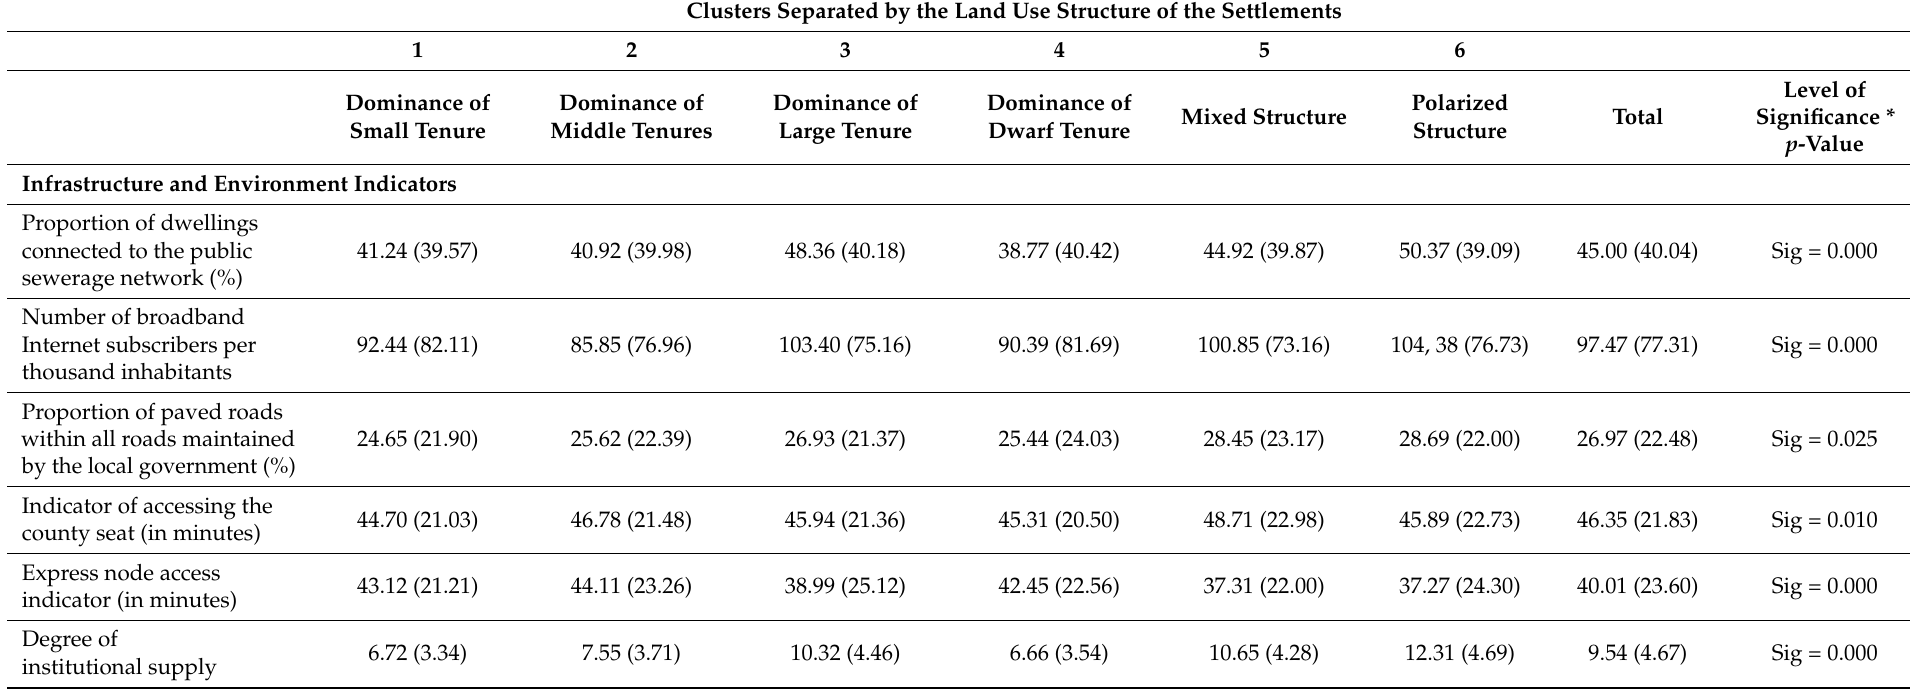
Table A5. Deviation of the six settlement clusters according to the indicators of infrastructure and environment, average values (corresponding standard deviations in